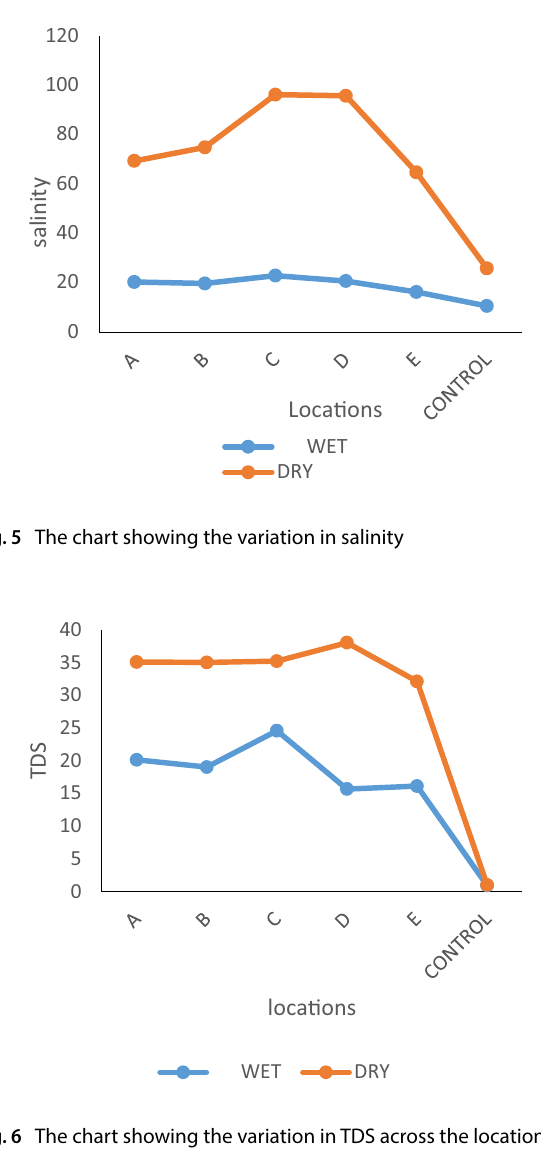
Fig. 6 The chart showing the variation in TDS across the locations